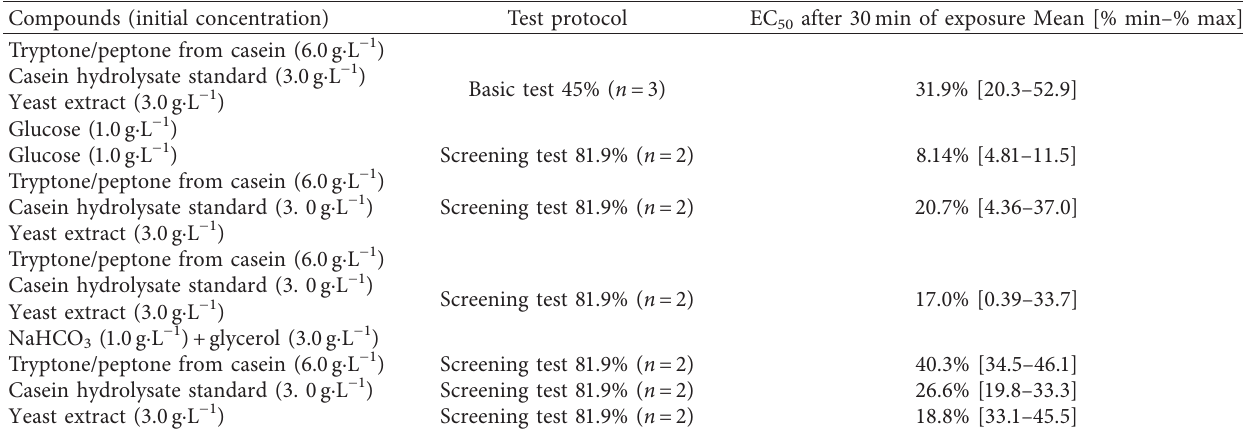
Table 4: EC 50 values obtained during the evaluation of the ecotoxicity of the medium used for degradation experiments. Compounds (initial concentration) Test